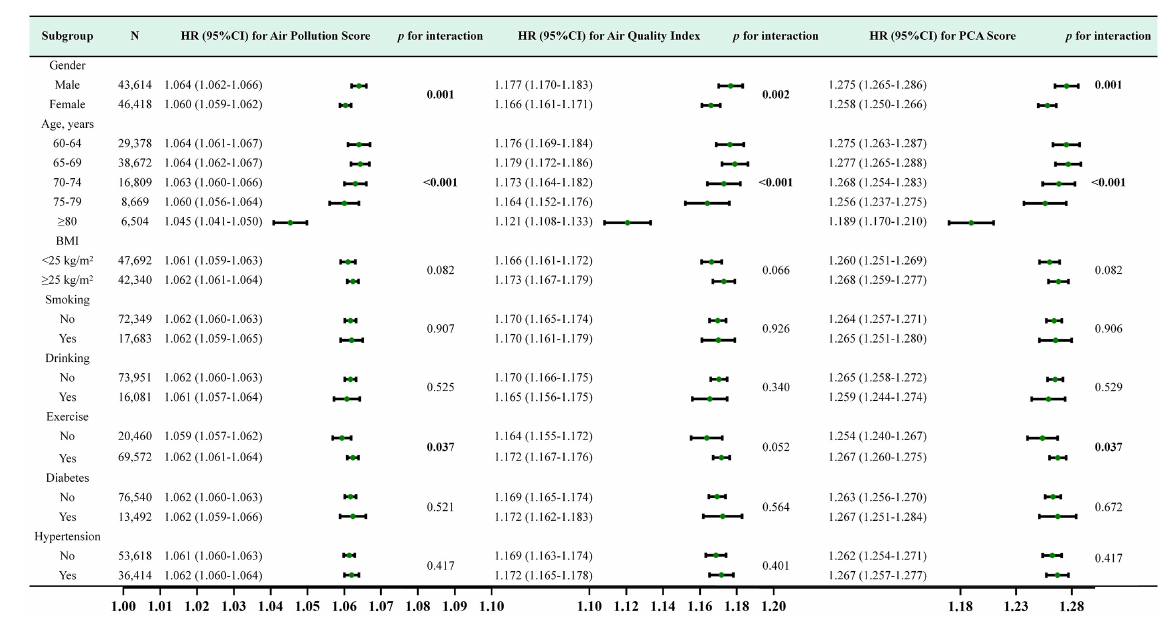
FIGURE5 Subgroup analysis and HR (95% CI) for air pollution score, air quality score and PCA score and CKD. All subgroup analyses adjusted for age, gender, BMI, smoking, drinking, exercise, history of diabetes, history of hypertension,WC, FBG, SBP, DBP, WBC, HGB, PLT, TC, TG, ALT, eGFR at